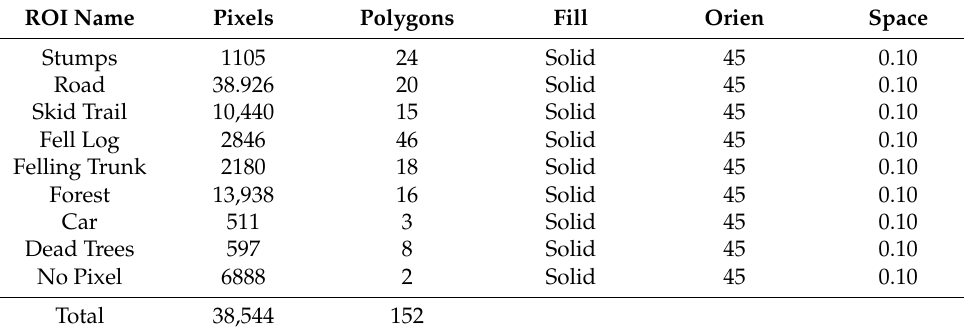
Table 4. Parameters used in CNN classification.